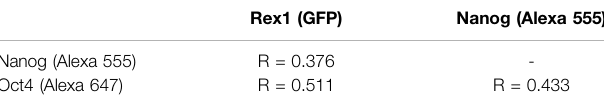
TABLE 3 | Correlations between fl uorescent staining/reporter intensities of major pluripotency associated factors.